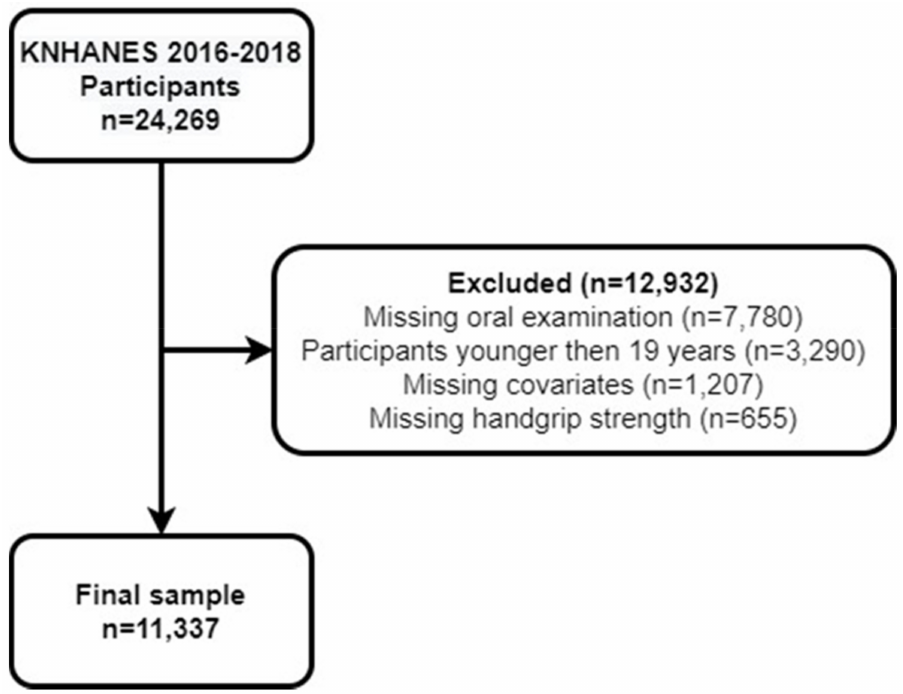
Figure 1. Flow chart of the selection